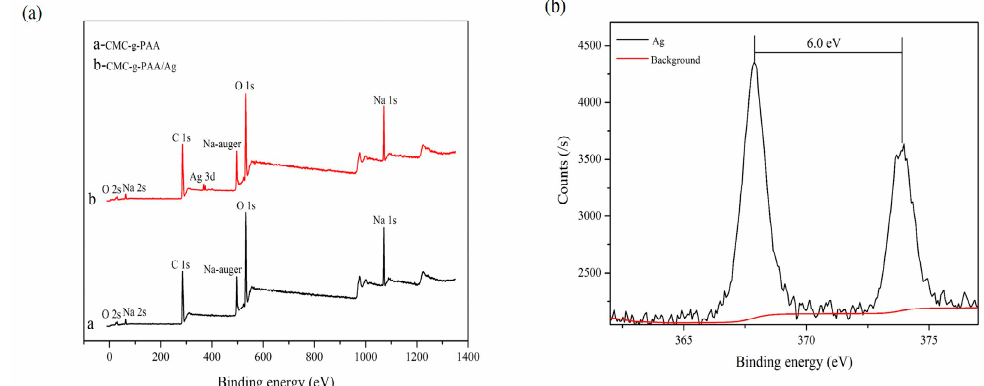
Figure 4. X-ray photoelectron spectroscopy (XPS) spectra of ( a ) CMC-g-PAA and CMC-g-PAA/Ag, ( b ) XPS peak of Ag (3d) in CMC-g-PAA/Ag.